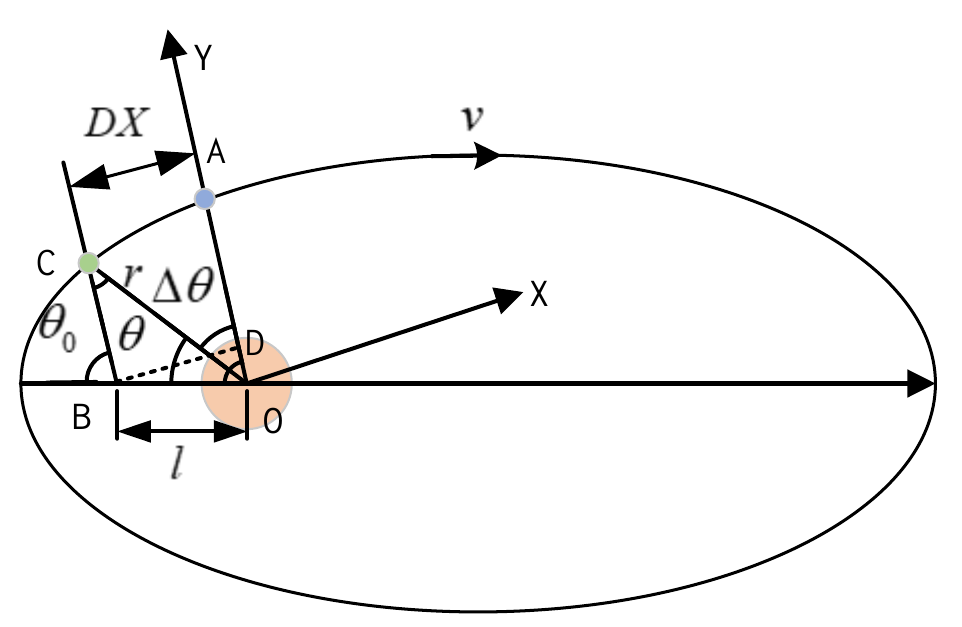
(17) The ATU-IGM updates the position of the injection point to eliminate the terminal position deviation. The original target point is marked as A , and the updated target point is marked as C . The parallel line of the OY axis is made through the point C and intersects with the semimajor axis at the point